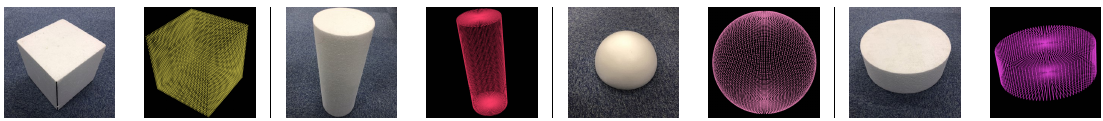
Figure 4. Primitive-shaped objects used in the experiment ( left ) and the generated point clouds ( right ) for each object. From left to right, cuboid, tall cylinder, sphere, and wide cylinder. The generated point clouds are used just as the evaluation and annotation of ground-truth pose.